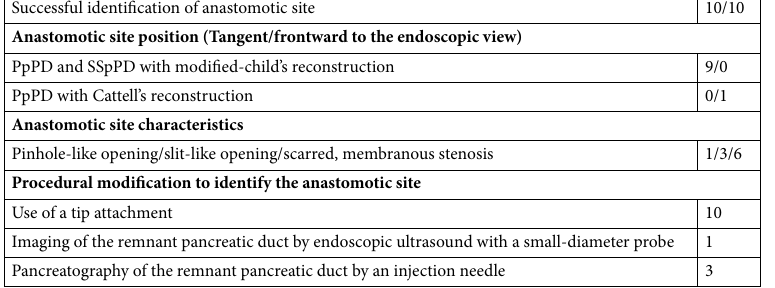
Table 2. Anastomotic site of sPJS. sPJS symptomatic pancreaticojejunal anastomotic stenosis, PpPD pylous- preserving pancreaticoduodenectomy, SSpPD subtotal stomach-preserving pancreaticoduodenectomy.